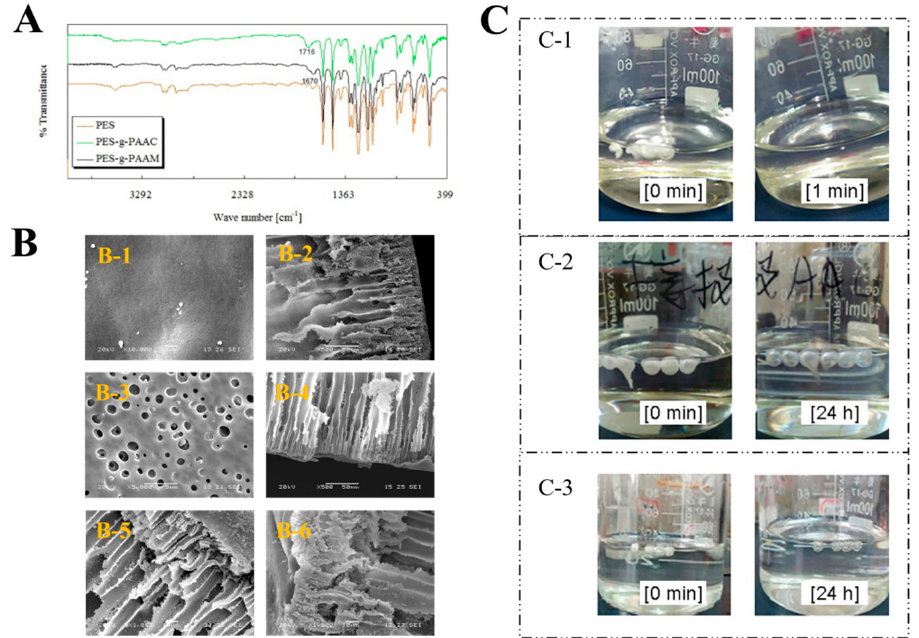
Figure 2. Characterization of the microcapsules. ( A ) The FT − IR spectra of blank PES microcapsules, PES microcapsules grafted with PAAC, and PES microcapsules grafted with PAAM. ( B ) Scanning electron microscopy images of ungrafted and grafted microcapsules. ( B − 1 ) Surfaces of PES microcapsules (Scale bar 1 µm). ( B − 2 ) Cross-sections of the PES microcapsules (Scale bar 50 µm). ( B − 3 ) Surfaces of modified PES microcapsules (Scale bar 5 µm). ( B − 4 ) Cross-sections of modified PES microcapsules (Scale bar 50 µm). ( B − 5 ) Cross sections of PES-g-PAAC microcapsules (Scale bar 10 µm). ( B − 6 ) Cross-sections of PES-g-PAAM microcapsules (Scale bar 10 µm). ( C ) The images of different PES microcapsules after being immersed in DMAC. ( C − 1 ) Blank PES microcapsules. ( C − 2 ) PES-g-PAAC microcapsules. ( C − 3 ) PES-g-PAAM microcapsules.